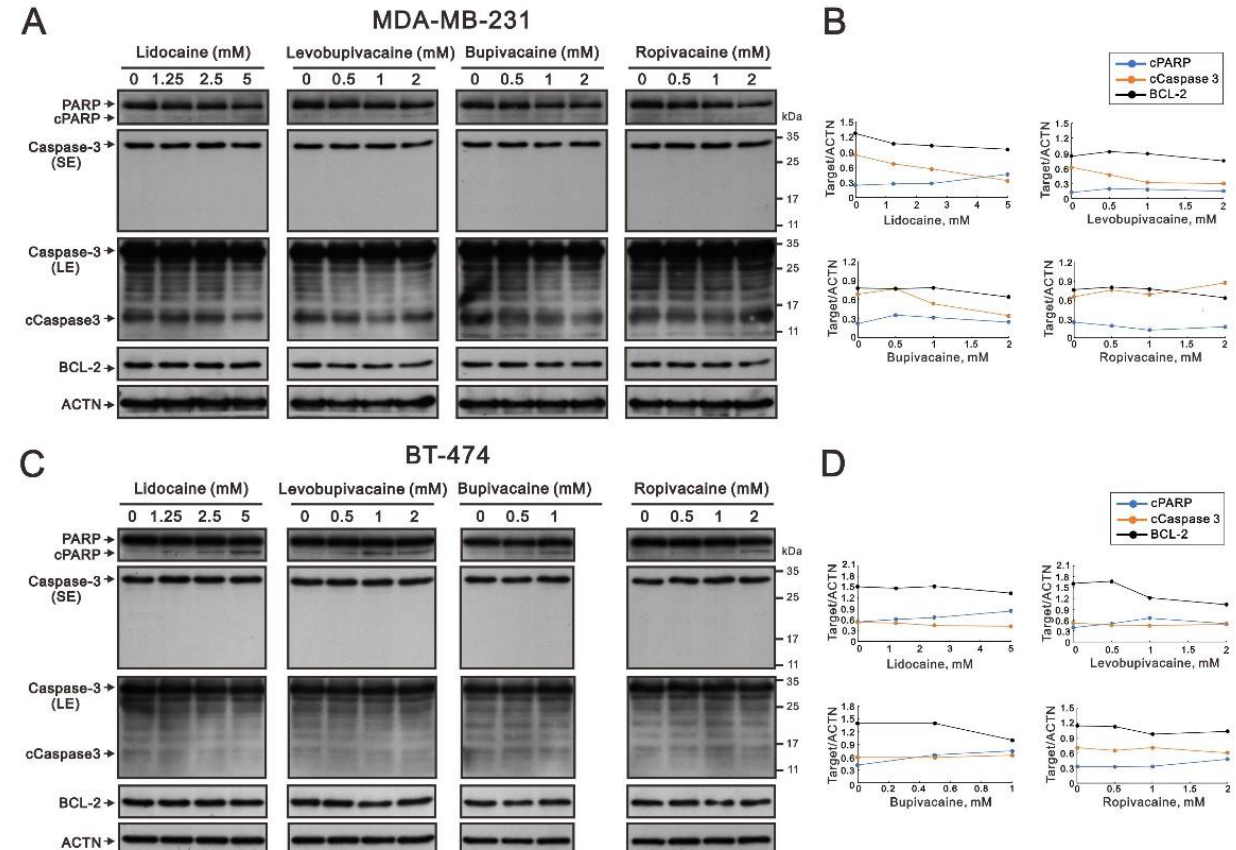
Figure 7. The effects of the local anesthetics on apoptosis-related protein expression in MDA-MB-231 and BT-474 cells. ( A ) MDA-MB-231 and ( C ) BT-474 (3 × 10 5 ) cells were treated with the indicated concentrations of lidocaine (1.25, 2.5, and 5 mM), levobupivacaine (0.5, 1, and 2 mM), bupivacaine (0.5 and 1 mM), and ropivacaine (0.5, 1, and 2 mM) for 24 h. The cell lysates were subjected to Western blotting analysis using antibodies against the indicated proteins. ACTN was used as the protein loading control. SE: shorter exposure; LE: longer exposure. ( B , D ) The protein bands ( A , C ) were quantified through pixel density scanning and evaluated using ImageJ, version 1.44a (http://imagej.nih.gov/ij/) (accessed on 4 December 2022). The ratios of protein/ACTN, including cPARP, cCaspase 3, and BCL-2) were plotted. The molecular weight markers are labeled with kDa. The roles of local anesthetics are not independent, and these agents are more likely to be used as chemo-sensitizers or synergistic therapies. Hence, we examined lidocaine, levobupivacaine, bupivacaine, and ropivacaine combined with the common chemotherapy drug doxorubicin using a combination index analysis of MDA-MB-231 and BT-474 cells (Figure 8A–H). Our data showed that for a combination index < 1, a synergistic effect was observed from the combination of ropivacaine and doxorubicin in MDA-MB-231 and BT-474 cells (Figure 8D,H) and from the combination of lidocaine and doxorubicin in MDA- MB-231 cells (Figure 8A). The concentration of doxorubicin with ropivacaine decreased from 0.75 µ M to 0.55 µ M in MDA-MB-231 cells and from 2.03 µ M to 0.75 µ M in BT-474